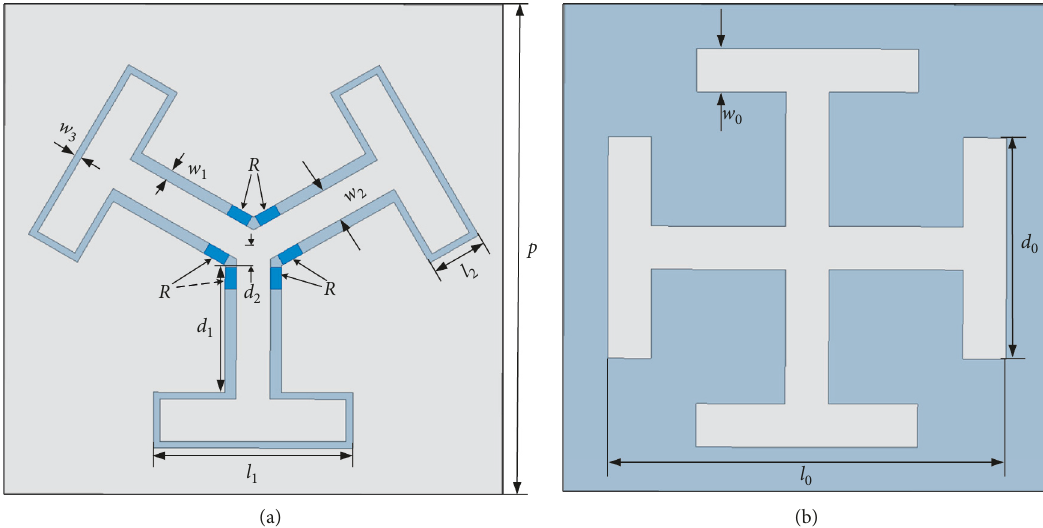
Figure 7: (a) Resistive layer on the top of the miniaturized design. (b) Bandpass layer at the bottom of the miniaturized design (geometric dimensions: p 22mm, h 13mm, w 1 (cid:30) (cid:30) . 96 mm, l w 0 (cid:30) 18mm, d 0 (cid:30) 0 (cid:30) 1